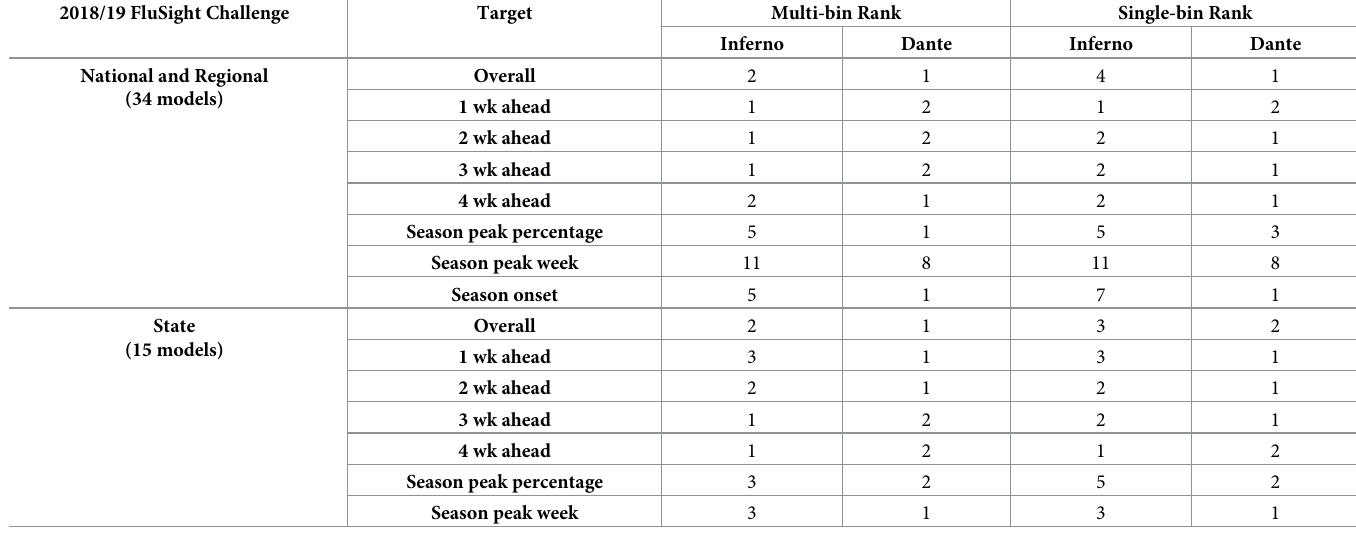
Table 1. The rank by challenge and target for Inferno and Dante as measured by single-bin and multi-bin skill. Inferno would have placed 2nd in both the National and Regional and the State challenges as measured by multi-bin skill, only finishing behind Dante. Inferno would have placed 4th (National and Regional) and 3rd (State) were the forecasts evaluated with single-bin skill. For both challenges and both evaluation metrics, Inferno achieved better short-term than seasonal